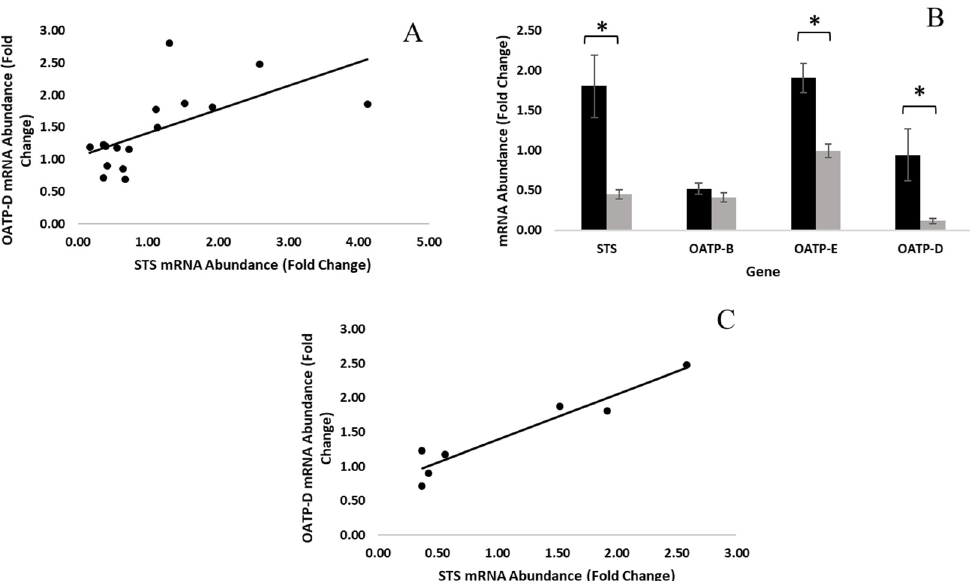
Figure 1. ( A ) The expression of STS in the fat was positively correlated (r = 0.63, p = 0.01) with the expression of OATP-D ( n = 16). ( B ) The expression of STS, OATP-B, OATP-E, and OATP-D was compared between boars classified as high-sulfatase (black, n = 8) or low-sulfatase (grey, n = 8) animals. Data are expressed as the mean ± standard error, and significant differences ( p < 0.05) are denoted by (*). ( C ) The expression of STS in the fat was positively correlated (r = 0.96, p < 0.01) with the expression of OATP-D in late maturing boars ( n = 7).